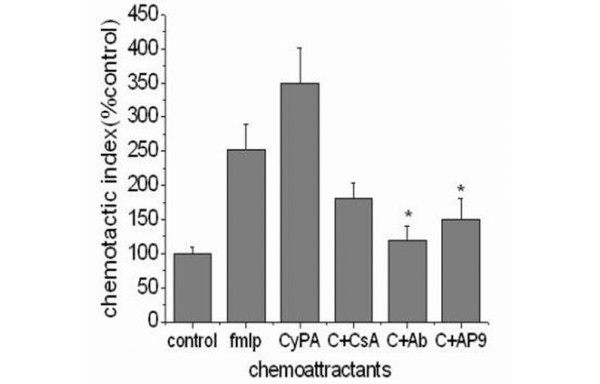
Effect of anti-CD147 antibody (Ab) and antagonistic peptide 9 (AP9) on the chemoattraction of cyclophilin A (CyPA). The chemotactic indexes decreased significantly when anti-CD147 antibody or AP9 was added. CsA, cyclosporine A. C, CyPA. fmlp, n-Formyl-Met-Leu-Phe, positive control.